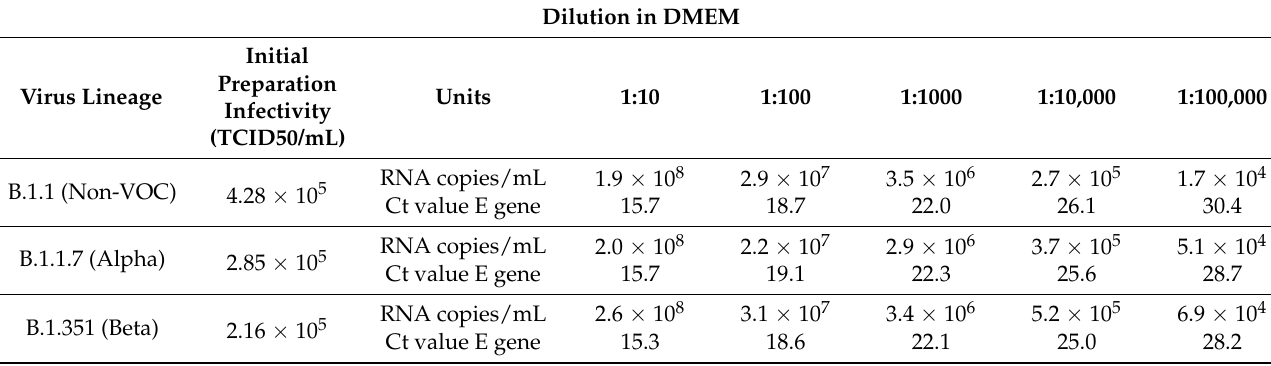
Table 3. Corresponding RNA copies/mL for all dilution steps based on